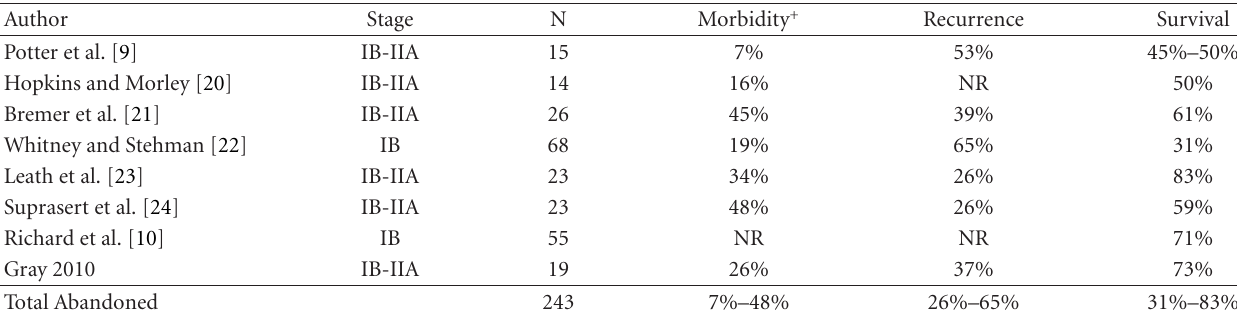
Table 3: Summary of published reports of abandoned